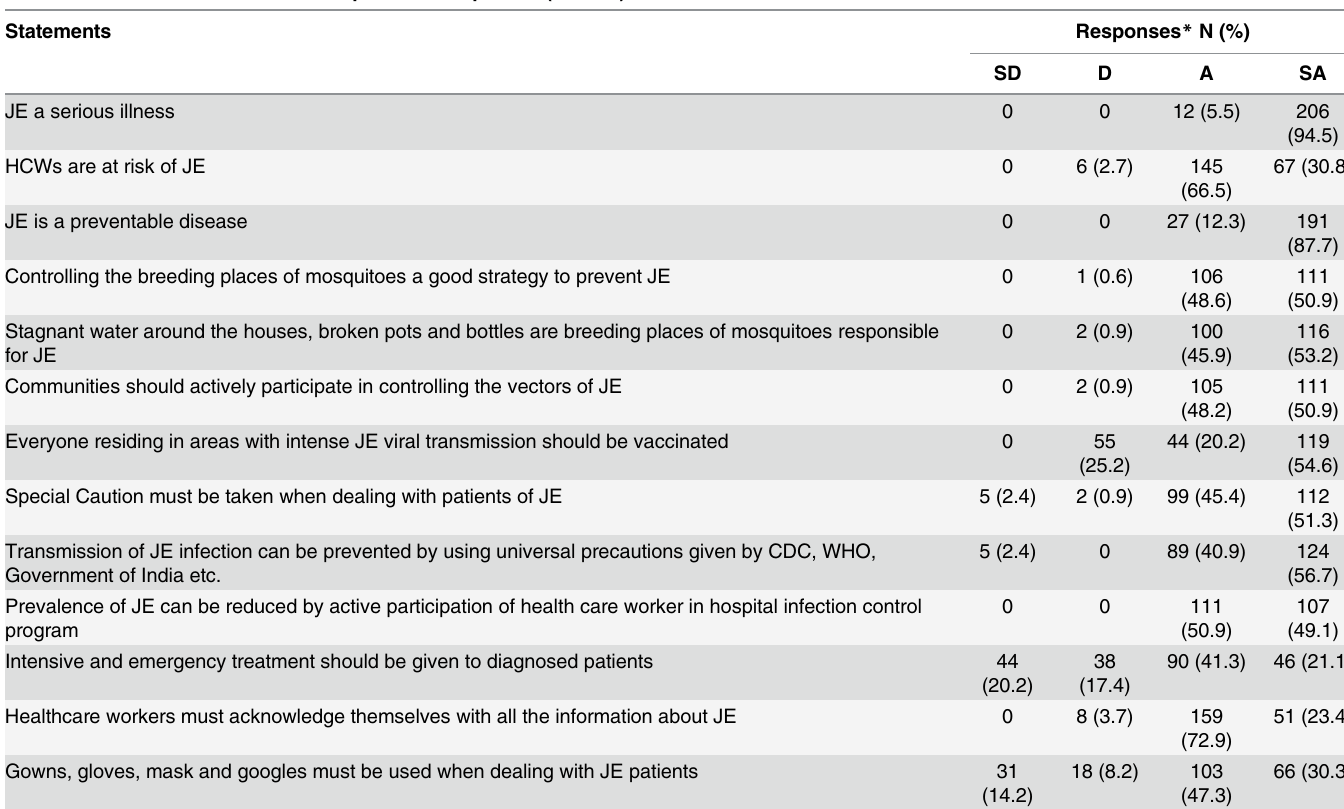
Table 4. Attitude of HCWs towards Japanese Encephalitis (N =